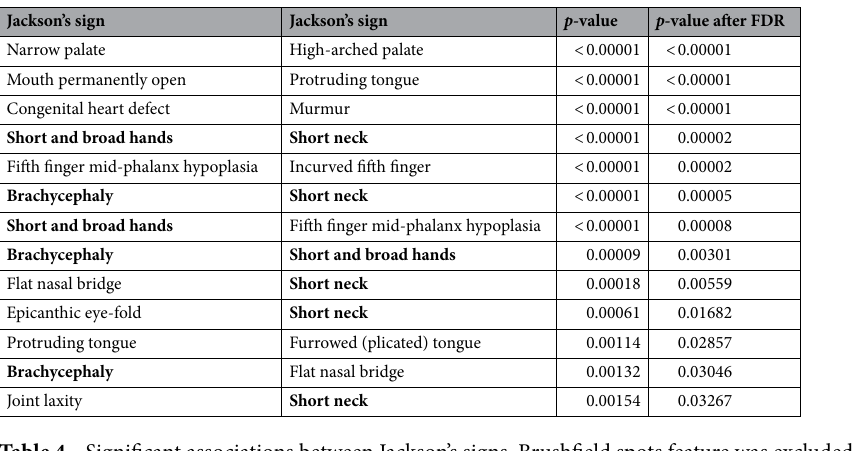
Table 4. Significant associations between Jackson’s signs. Brushfield spots feature was excluded. Signs are sorted by increasing p -value after false discovery rate (FDR) correction. Most recurrent features are highlighted in bold. The whole set of all possible associations is shown in Supplementary Table 2.